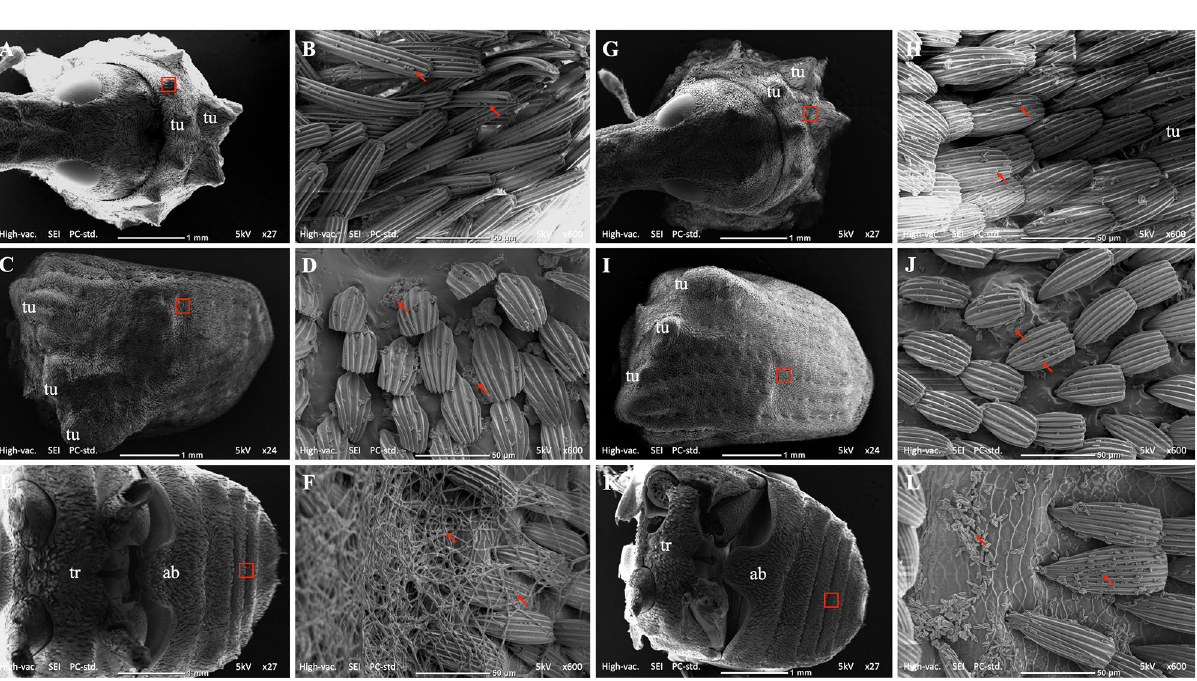
Figure 7. ( A , G ) Anterior dorsal view of the pronotum showing tubercles, ( B , H ) fungal conidia attached on scales around the tubercle, ( C , I ) Dorsal view of the elytron showing tubercles; ( D , J ) fungal conidia attached to the scales of the elytron, ( E , K ) Ventral view of the thorax (tr) and abdomen (ab), ( F , L ) fungal conidia germinated or attached to the scales of the abdomen. The red arrows point at the conidia or the germinated conidia of B27 ( B , D , F ) and ECS1 ( H , J , L ). As there were numerous conidia either attached to, or germinated on the weevil, the arrows are used to indicate examples. Red boxes indicate areas shown at higher magnification in other